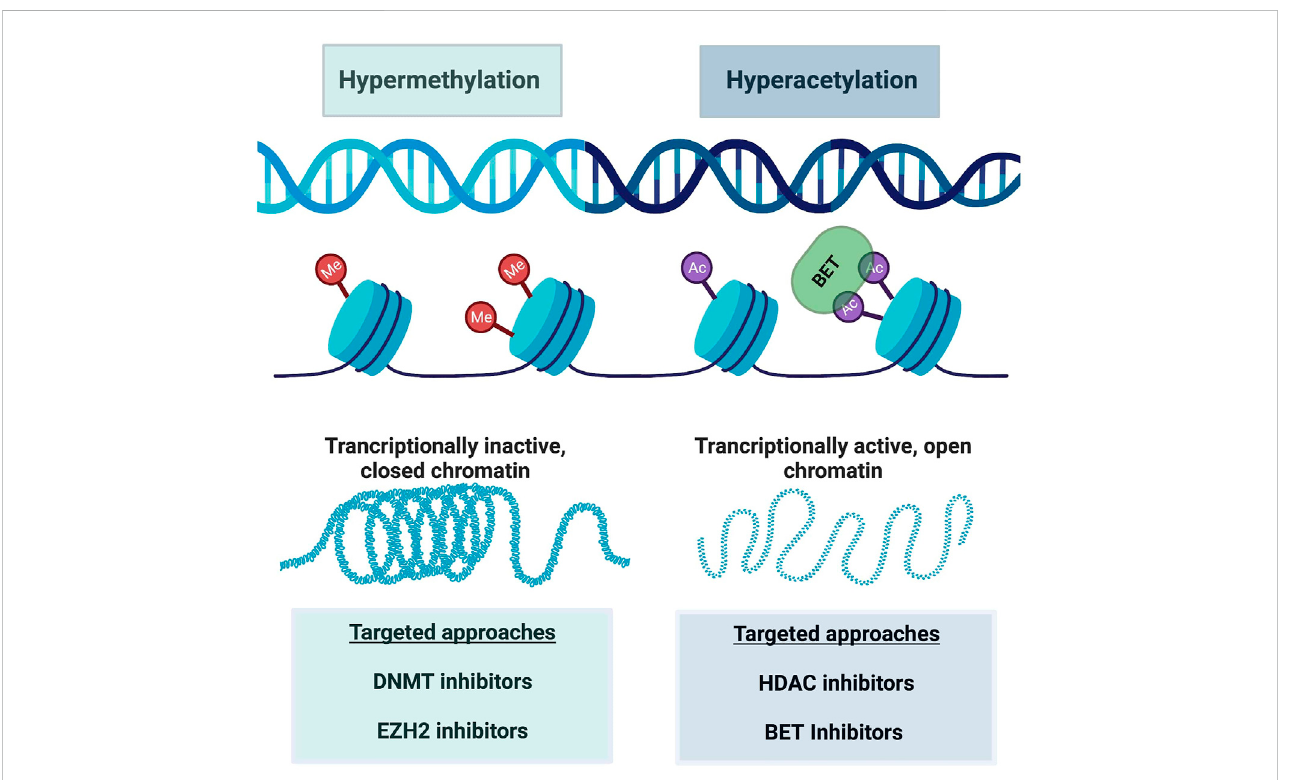
FIGURE 3 A schematic of major epigenetic alterations reinforcing CD8 + T cell exhaustion. Hypermethylation is characterized by increased methyl group attachment to DNA on chromatin, making the DNA transcriptionally inactive and closed. Hyperacetylation on the other hand acts in an opposite manner, where acetyl group binding causes chromatin to open and enhanced transcription of DNA. BET targeting to acetyl groups can also modify this transcription. These alterations are manipulated by various targeted drug approaches as listed in this fi gure. Created with